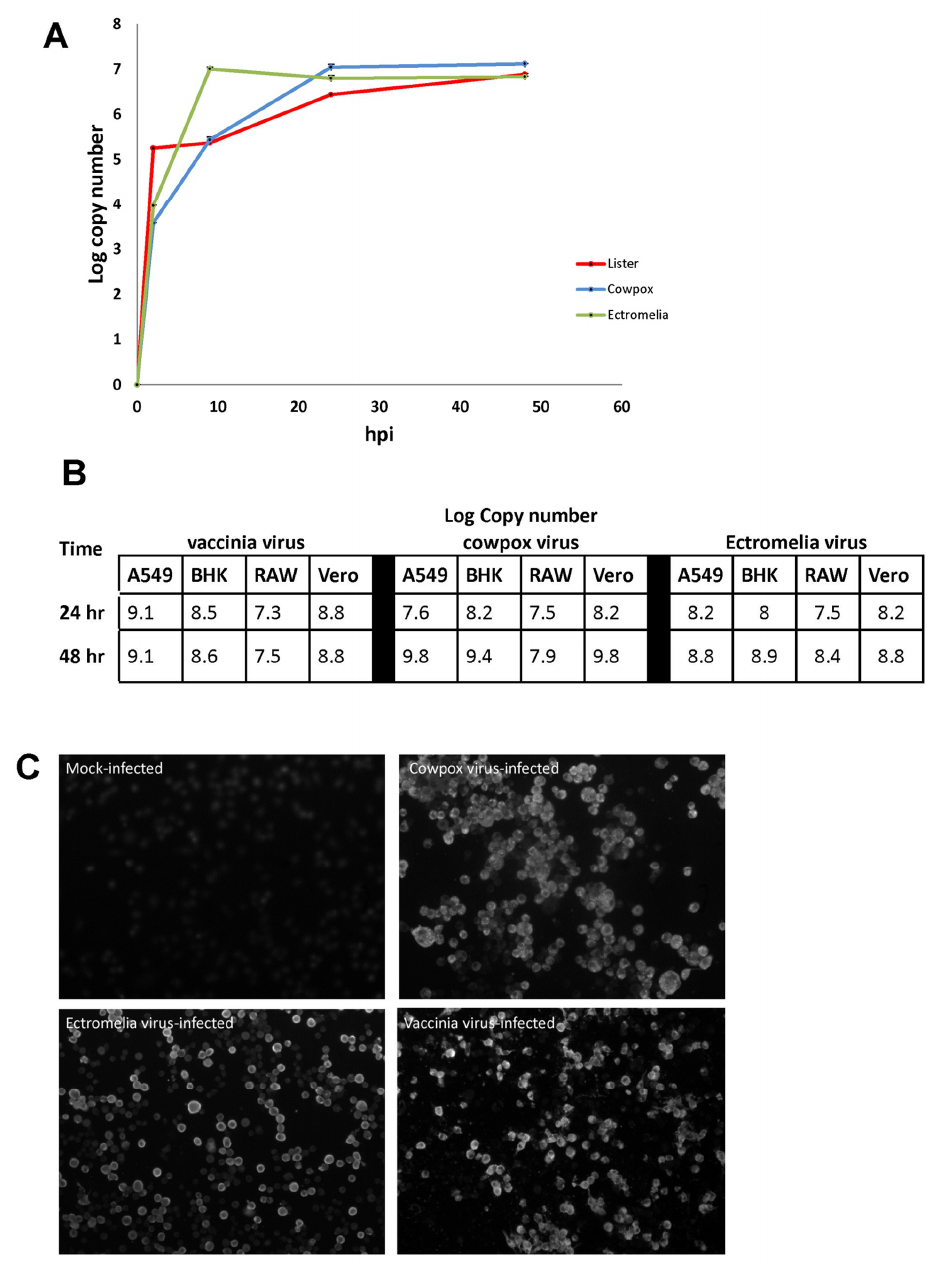
Figure 1. Examination of RAW cells infected with cowpox virus (CPXV), ectromelia virus (ECTV) and vaccinia virus (VACV) using quantitative PCR (qPCR) to measure the virus replication kinetics and immunofluorescence microscopy to measure infectivity. ( A ) RAW cells were infected with each poxvirus and the virus replication kinetics measured at 2, 10, 24 and 48 h post-infection (hpi) with qPCR. The growth curve is plotted with viral genome copies as log copy number on the y-axis and time of infection as hpi on the x-axis ( ♦ represent VACV; ■ represents CPXV; ▲ represents ECTV). ( B ) A549, BHK, RAW and VERO cells were infected with each poxvirus and the virus replication kinetics measured at 24 and 48 hpi with qPCR. ( C ) RAW cells were mock-infected and infected with each poxvirus and at 16 hpi, stained with anti-VACV and examined using immunoflorescence microscopy (objective ×20).